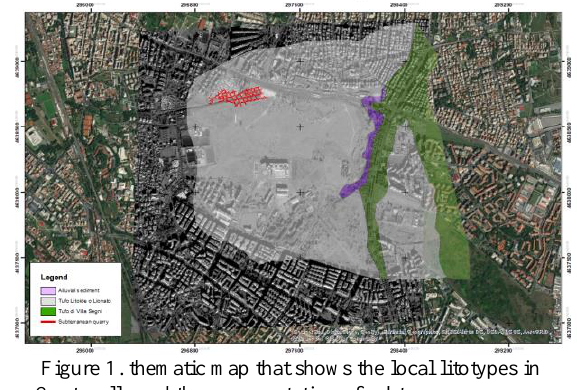
Figure 1. thematic map that shows the local litotypes in Centocelle and the representation of subterranean quarry